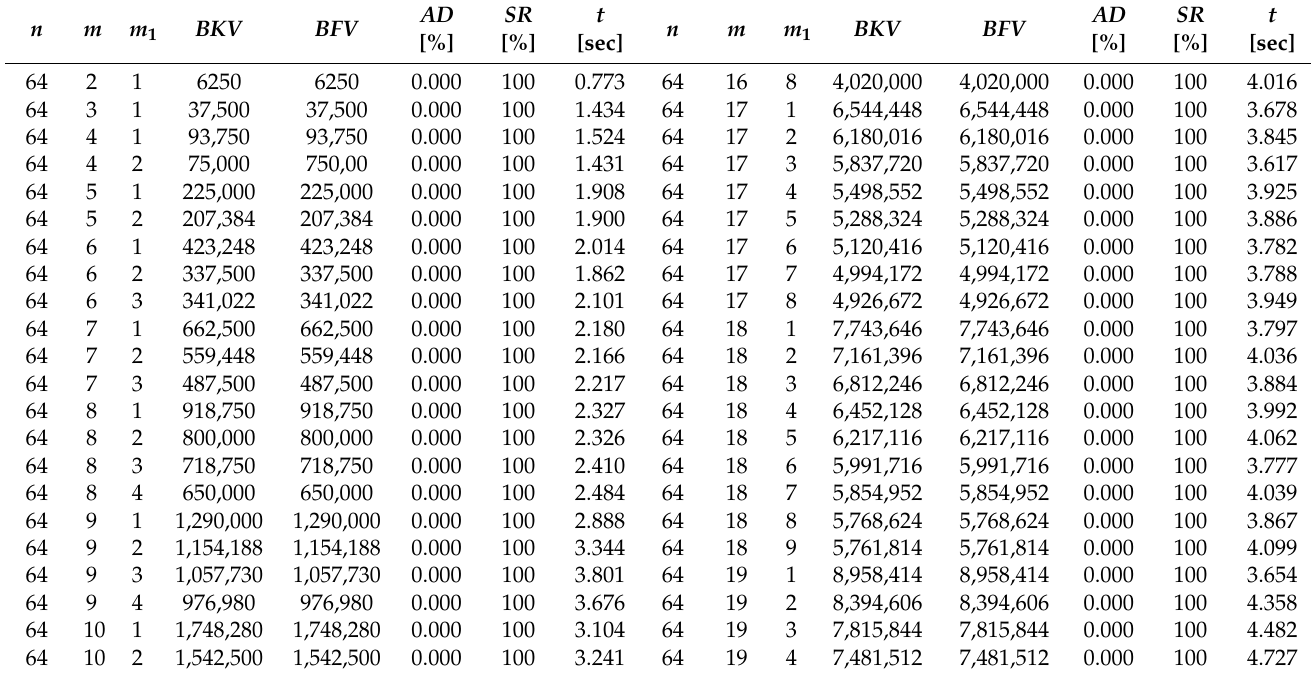
Table 2. Results of the computational experiments (part